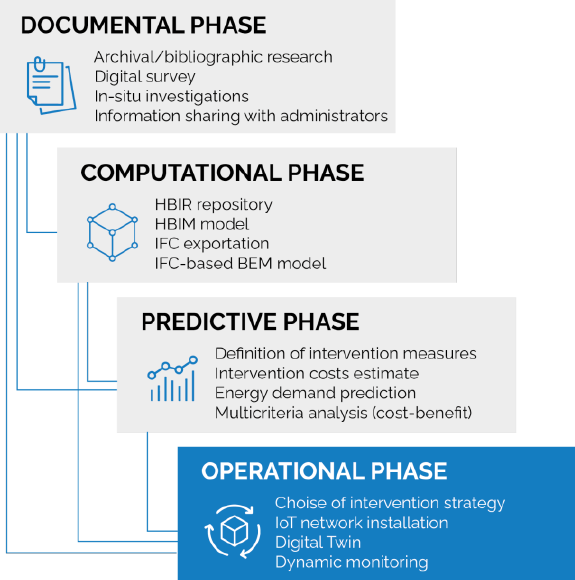
Figure 1. The HBIM-based workflow for the energy improvement of modern